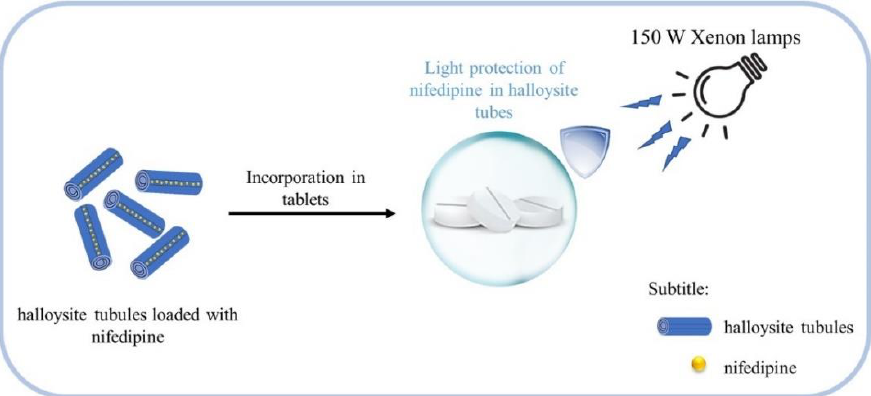
Figure 3. Scheme of nifedipine-loaded halloysite for study of photostability by Yendluri et al. 2017.